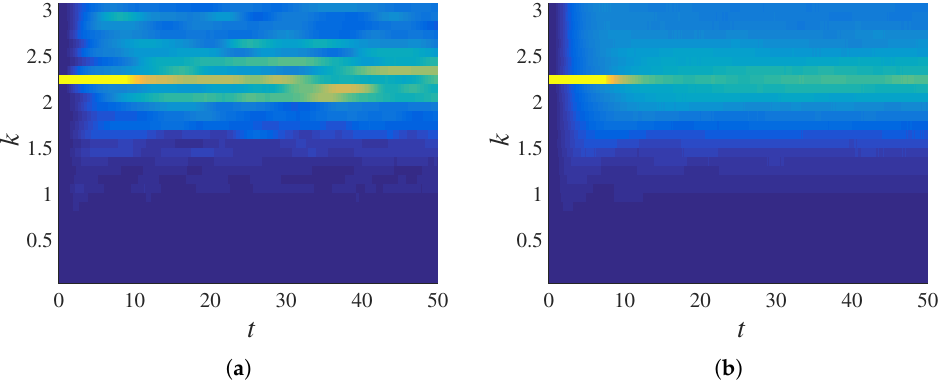
Figure 12. Binned total energy response of Figure 11a for ( a ) a single realization (ˆ e ( 23 ) ( t ) ) and ( b ) ˆ e ( 23 ) ( t ) averaged over 100 ensembles ( ), with k ins = 2.159 ( h i N = 90), which gives bin number s = 23. The number of particles of a simulation, i.e., the system size, can have a big influence on the simulation results. For this reason, two system sizes were chosen ( N = 128, 512) along with the one used earlier ( N = 256). Simulations with different sizes led to qualitatively and quantitatively similar results (data not shown).